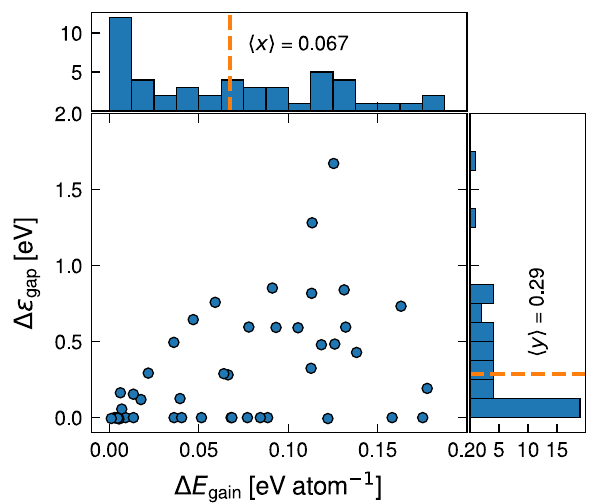
Fig. 5 Energy above the convex hull before and after the stabilization. The energy above the convex hull for the 49 monolayers before and after distortion. Materials with a Δ H ð after Þ close to zero are expected to be thermodynamically stable. The range up to 0.05 eVatom − 1 above the convex hull has been indicated by a shaded blue region to visualize the importance of structural distortions for assessing the thermodynamic stability.